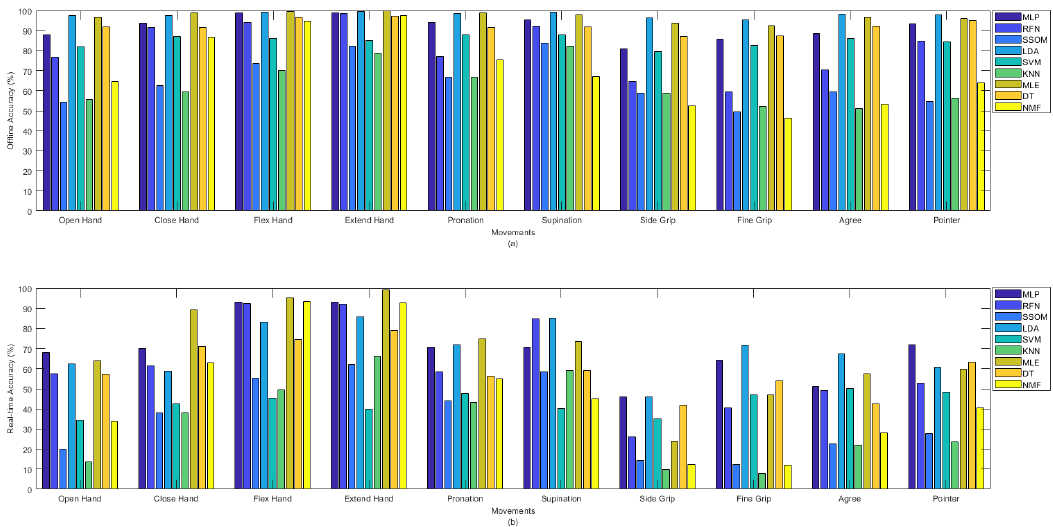
Figure 4. ( a ) Offline and ( b ) real ‐ time average accuracies over 15 subjects between classifiers per